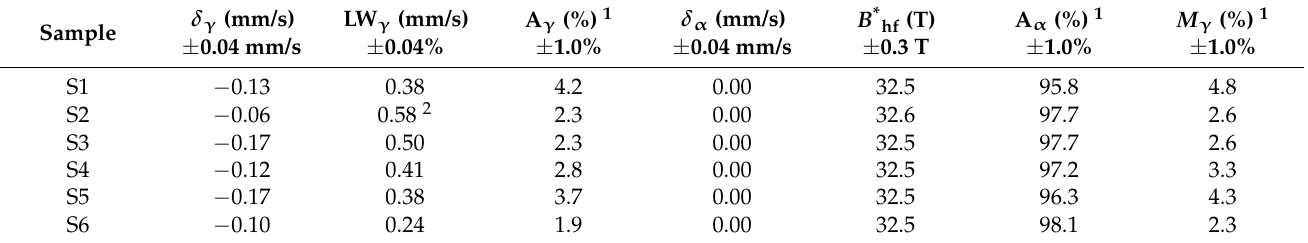
Table 3. Austenite and martensite contents in primary samples resulting from Mössbauer spectroscopy analysis, where δ γ and δ α is isomer shift of austenite and martensite pattern resp., LW γ is a line width of austenite, A γ is a relative area of austenite in the spectrum, B * hf is an average hyperfine field of the martensite subspectrum, A α is a relative area of martensite in the spectrum, M γ is the amount of retained austenite according to Equation (1).